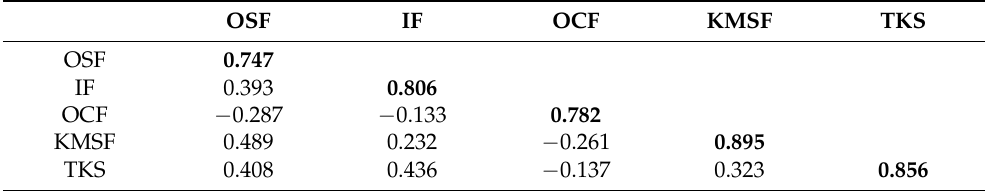
Table 3. Discriminant validity.